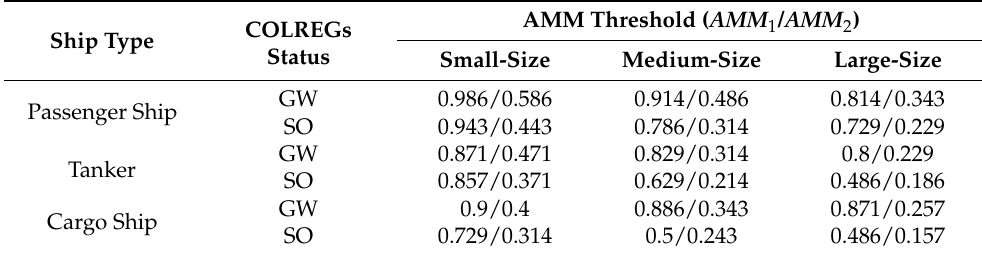
Table 2. The value of AMM at the boundary of risk-perception-based ship